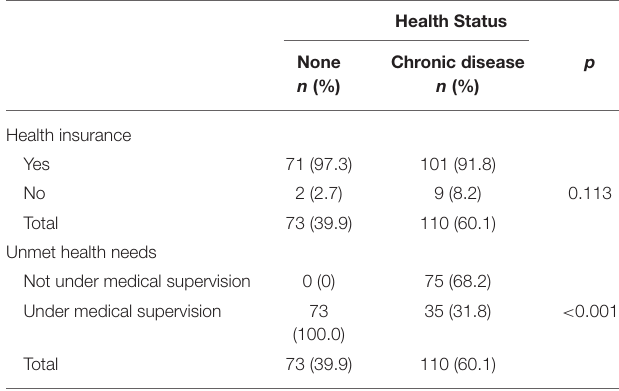
TABLE 3 | Relationship between health status, health insurance, and medical supervision.